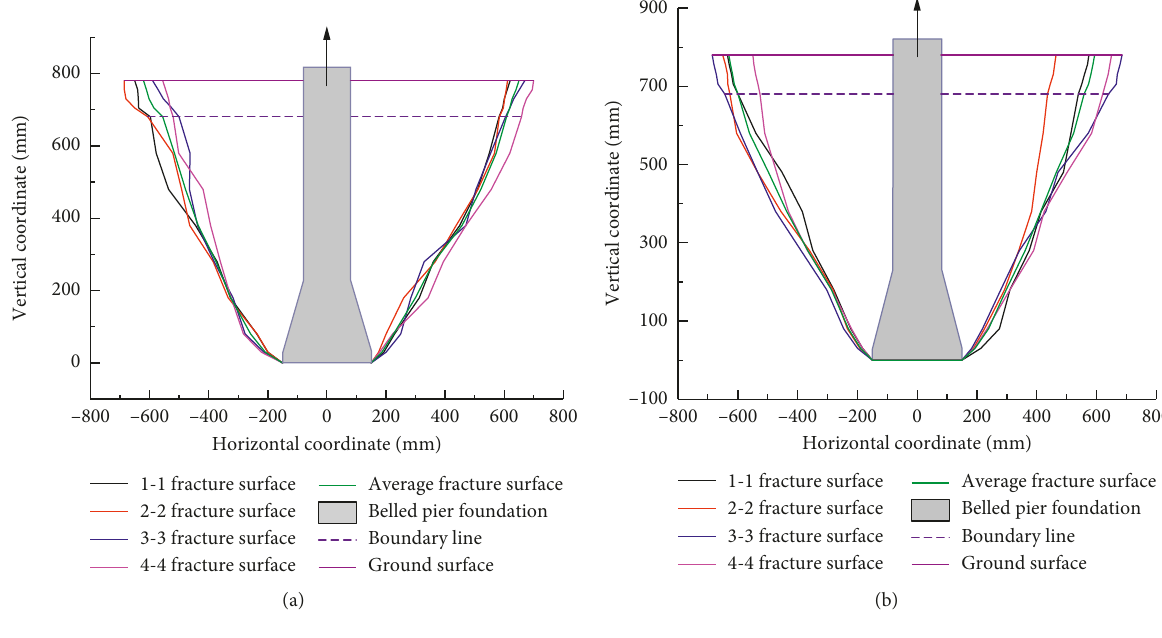
Figure 11: Ground displacement at uplift loading. (a) Test II. (b) Test IV.